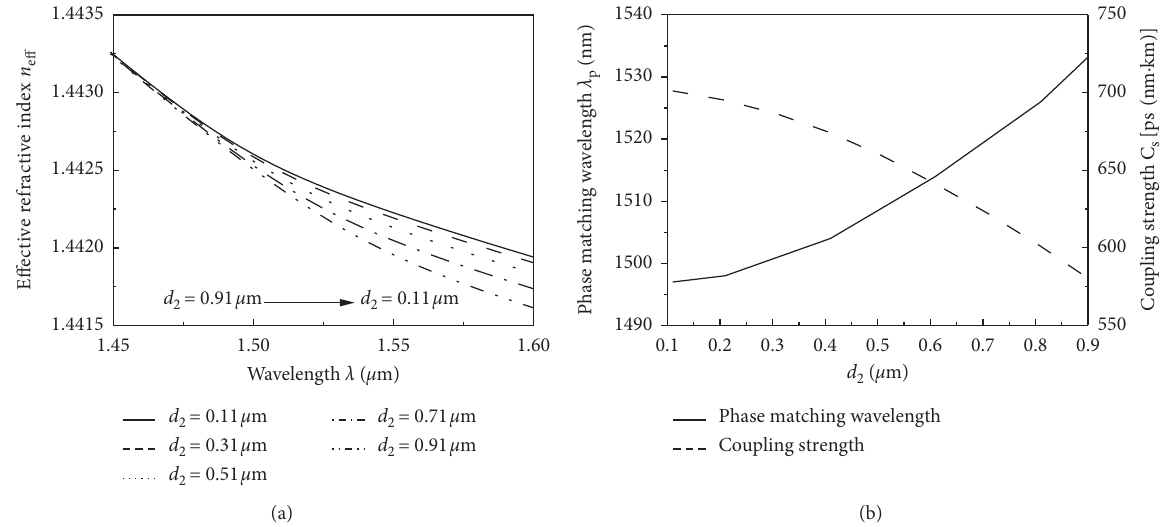
Figure 5: Variation of the effective refractive index of the fundamental supermodel with wavelength when d coupling strength with d 2 (b).